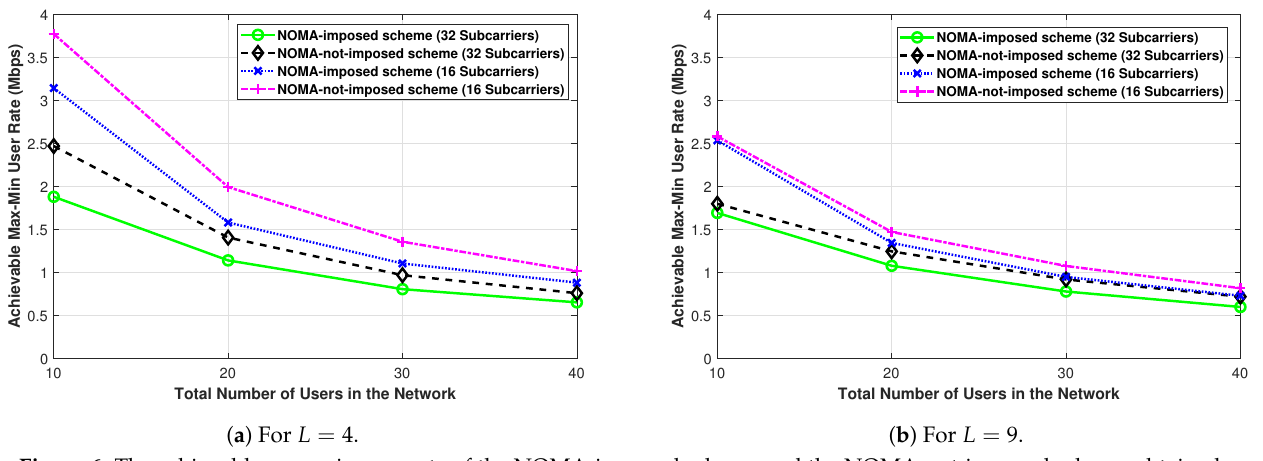
Figure 6. The achievable max-min user rate of the NOMA-imposed scheme and the NOMA-not-imposed scheme obtained while changing the total number of users in the network. ( P e = 35 dBm, φ 1/2 = 60 ◦ , Ψ 1/2 = 85 ◦